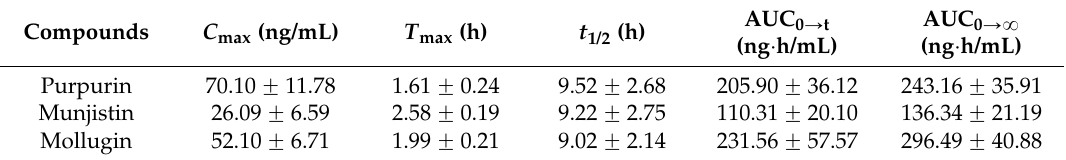
Table 6. Pharmacokinetic parameters of the three constituents in rats after oral administration of R. cordifolia extract. (mean ˘ SD, n =